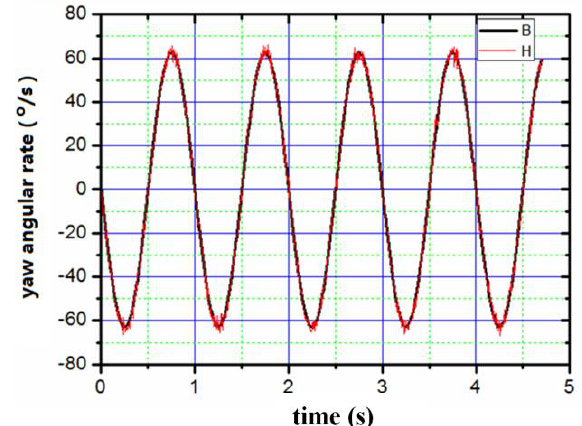
Figure 9. Comparison between the input yaw angular rate and the output yaw angular rate. B ： the input of yaw angular rate ； H ： the output of yaw angular rate.